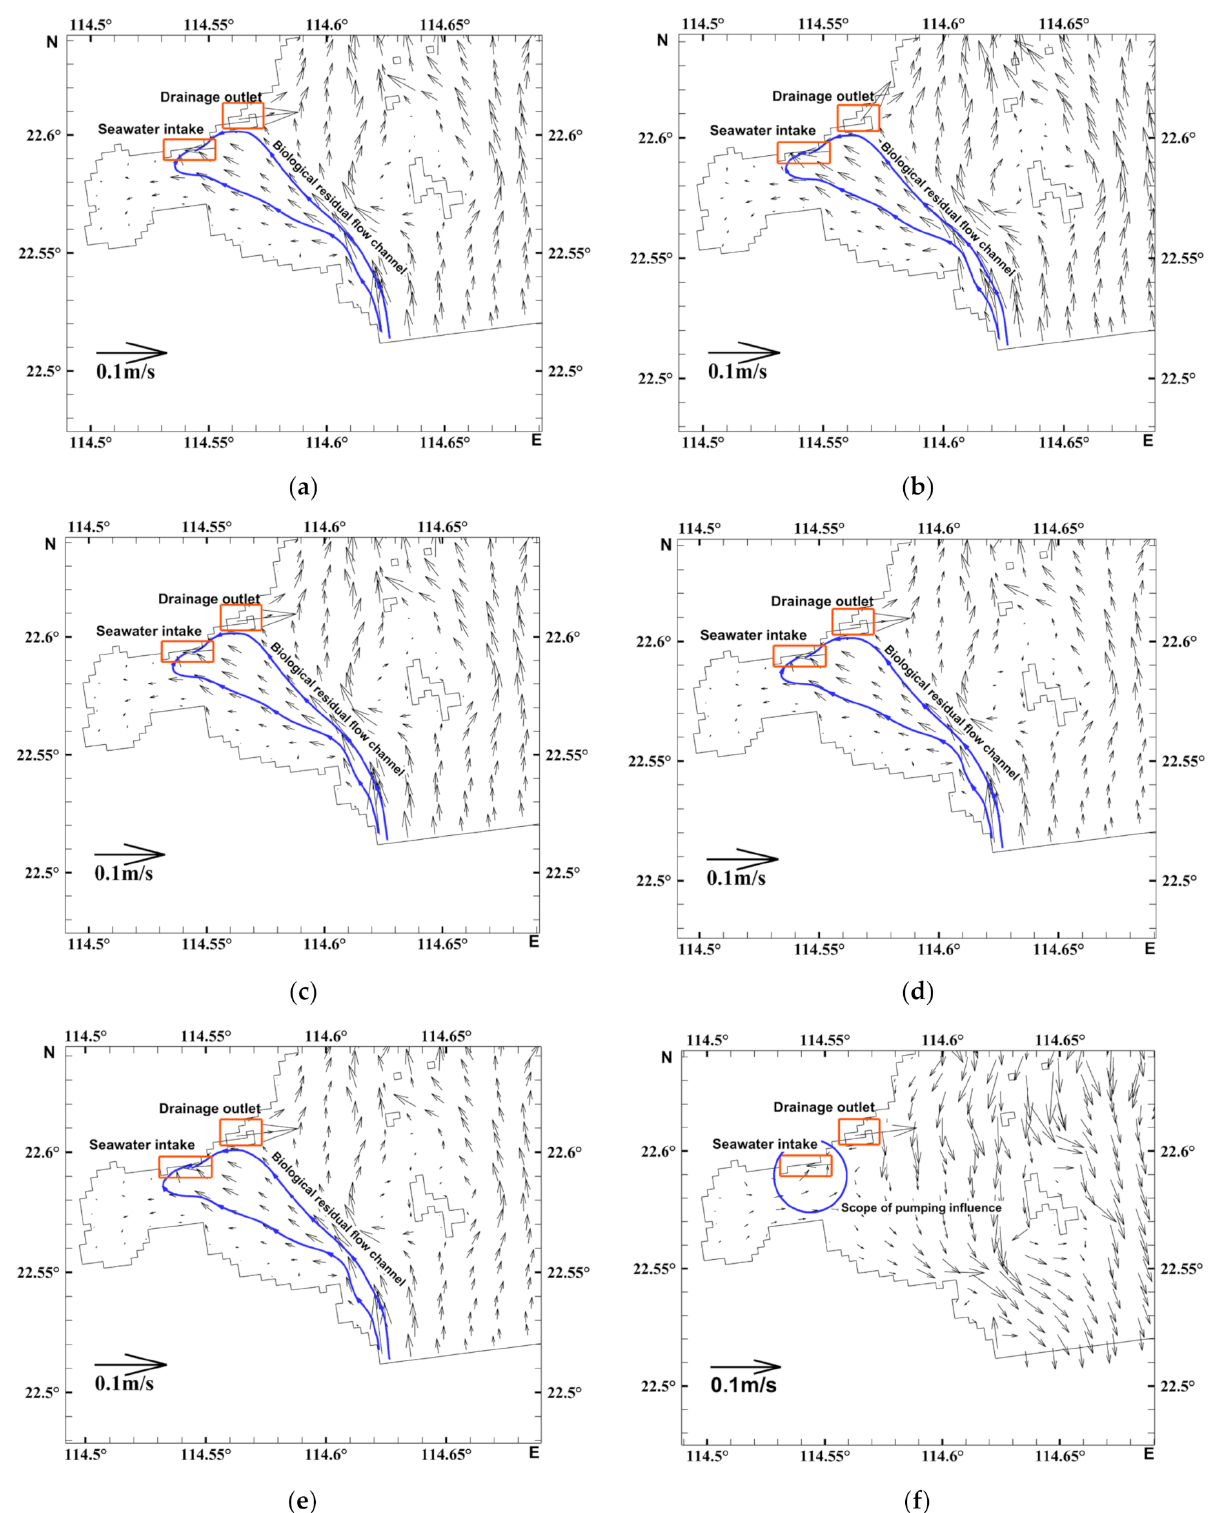
Figure 8. Residual flow field of inflow periods: ( a ) 12 h night-migration period; ( b ) 13 h night- migration period; ( c ) 14 h night-migration period; ( d ) 15 h night-migration period; ( e ) 16 h night- migration period; ( f ) residual flow field of outflow period with a 14 h night-migration